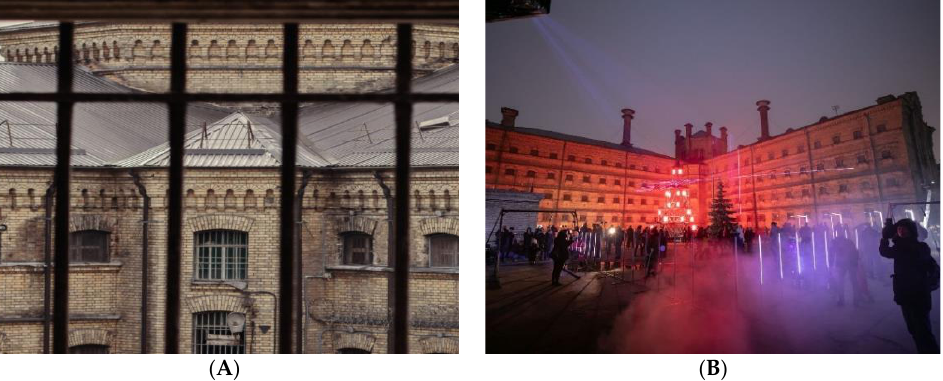
Figure 16. ( A ) Lukiškės prison . Available online: https://tinyurl.com/2dfer723 (accessed on